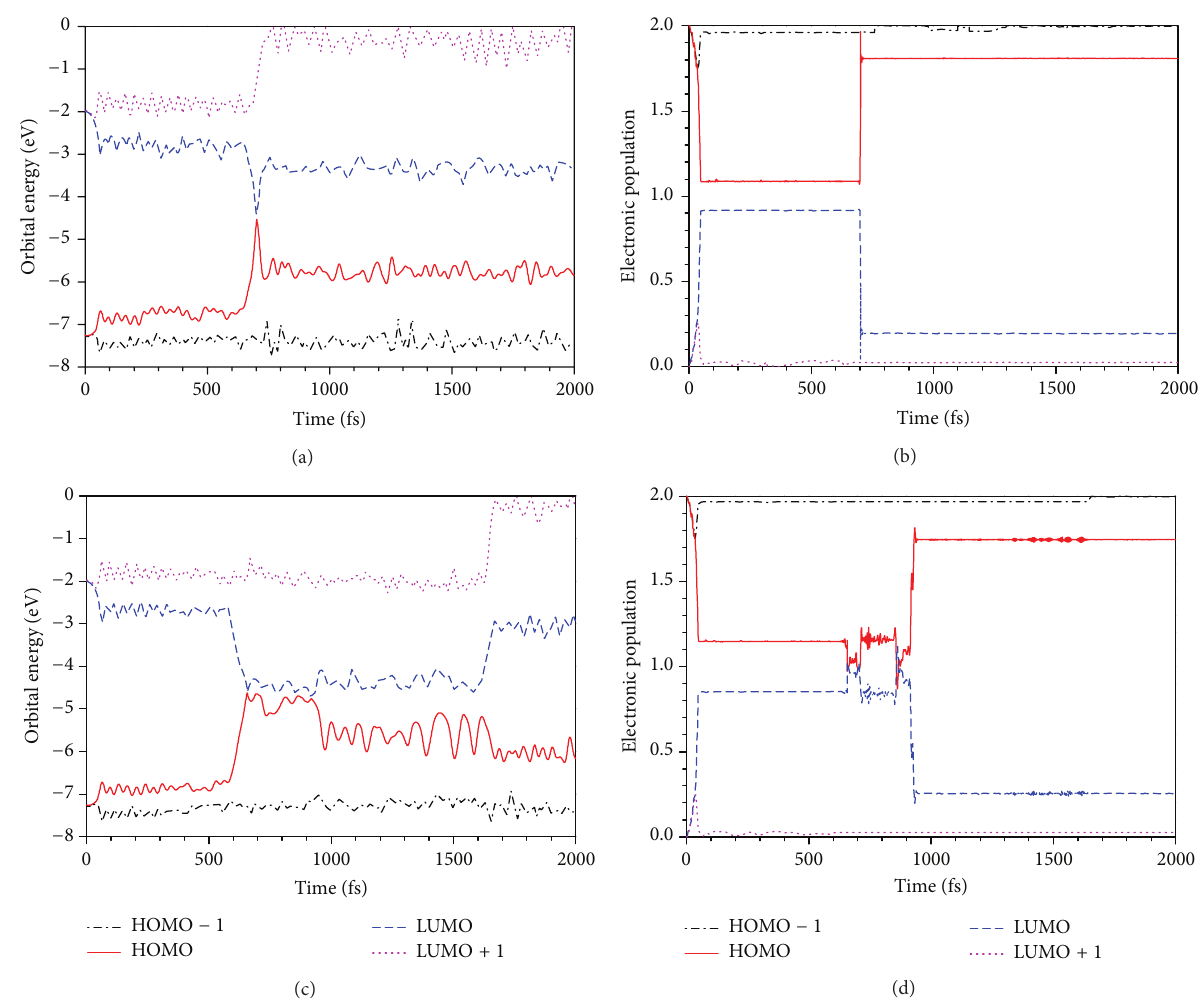
Figure5:Thevariationswithtimeof(a)theHOMOandLUMOenergies; (b)thetime-dependentpopulationofstackedbenzeneandethylene system in synchronous mode, which is subjected to a laser with frequency of 4.7 eV and fluency of 96.93 J ⋅ m −2 ; (c) and (d) are the HOMO and LUMO energies and the time-dependent population in asynchronous mode, which is subjected to a laser with frequency of 4.7 eV and fluence of 94.11J ⋅ m −2